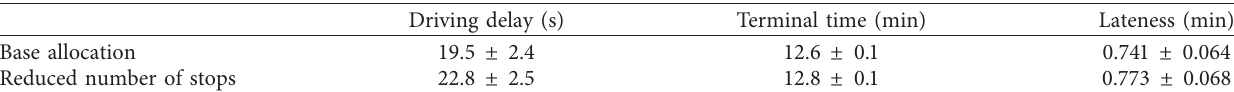
Table 4: Results for the reallocation of lines to stops scenario in the form of average values with 95% confidence